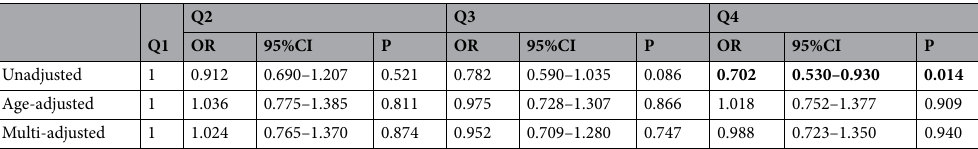
Table 4. Results of multinomial logistic regression analysis for the association between ED risk and osteocalcin level. * The levels of osteocalcin is divided into quartile (Q1 < levels of 25%, 25% ≤ Q2 ≤ 50%, 50% < Q3 ≤ 75%, Q4 > 75%). * Multi-adjusted: adjust for age, smoking status, alcoholic drinking, BMI, WHR. * ED = erectile dysfunction; BMI = Body Mass Index; WHR = waist hip